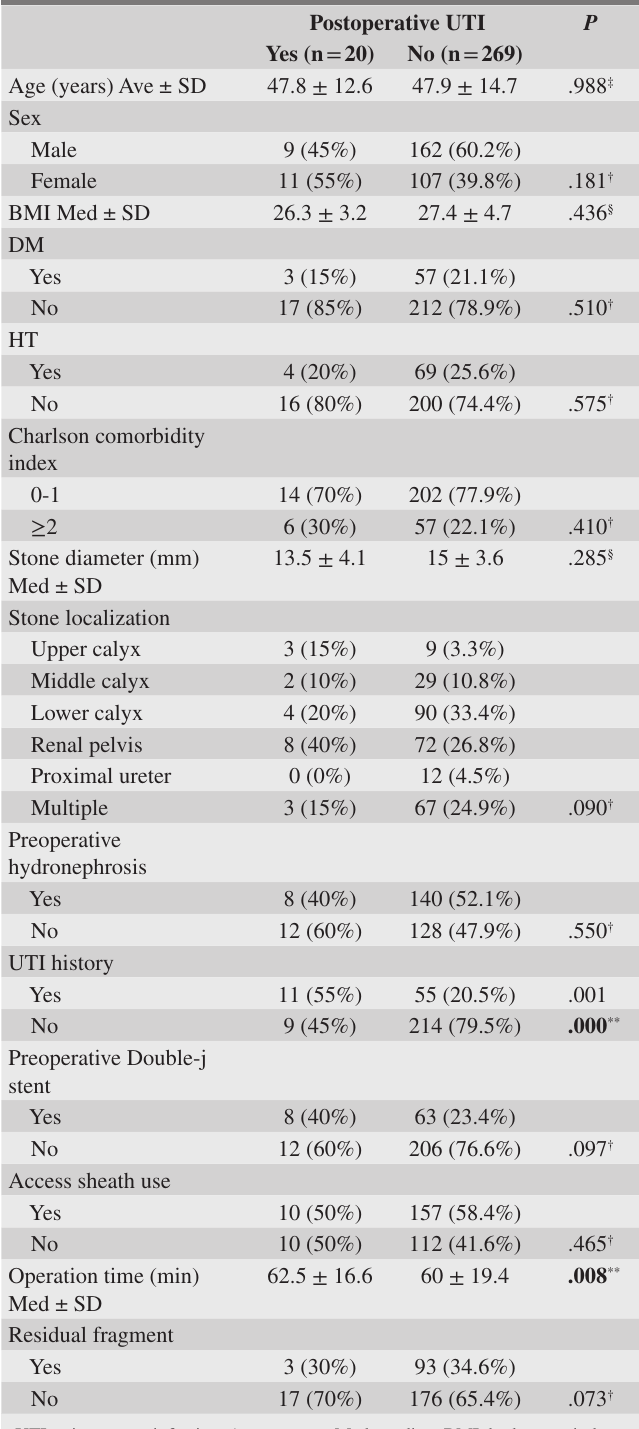
Table 1. Perioperative and Demographic Features